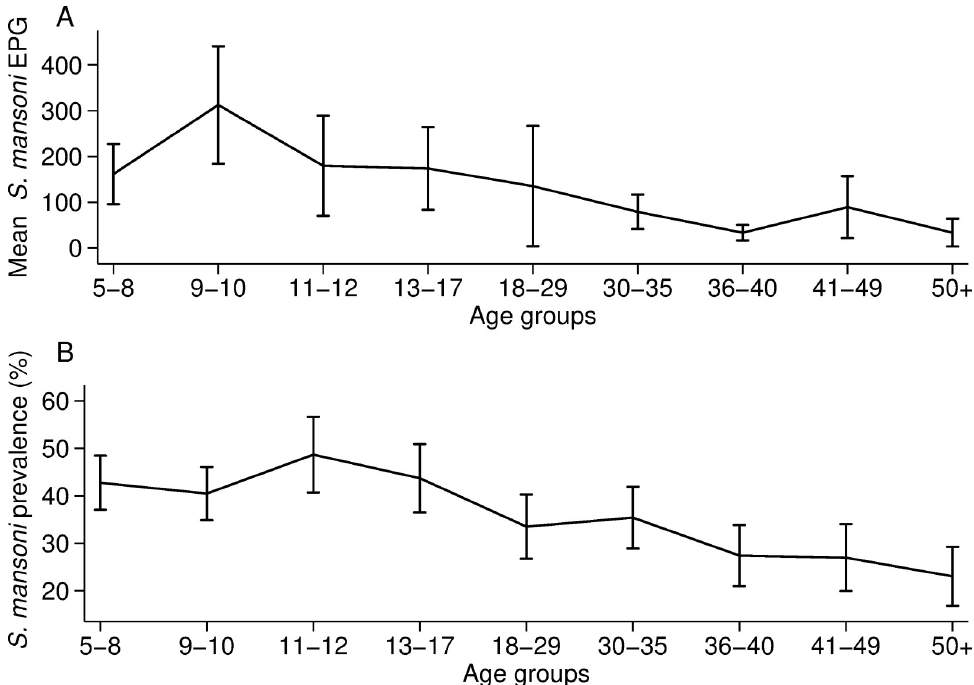
Fig 1. S . mansoni prevalence and infection intensity against age. A) Arithmetic mean of S . mansoni eggs per gram (EPG) for each age group with the corresponding 95% confidence intervals. B) S . mansoni prevalence for each age group with the corresponding 95% confidence intervals. In panel A, one child and one adult (aged 9 and 25 years) were outliers ( > 11,000 EPG) and were replaced with the next highest EPG in the age group. The number of individuals per age group are reported in S1 Table in S1